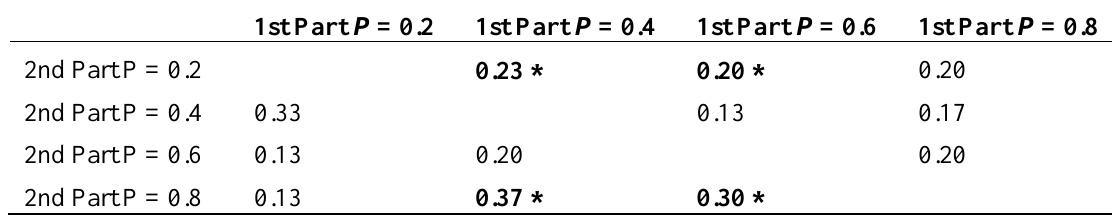
Table 4. Part 2 Average Conflict Rates for All 12 Sessions, Sorted by Current Power Treatment (Rows) and Previous Power Treatment (Columns). 1st Part P = 0.2 1st Part P = 0.4 1st Part P = 0.6 1st Part P = 0.8 2nd Part P = 0.2 0.23 * 0.20 * 0.20 2nd Part P = 0.4 0.33 0.13 0.17 2nd Part P = 0.6 0.13 0.20 0.20 2nd Part P = 0.8 0.13 0.37 * 0.30